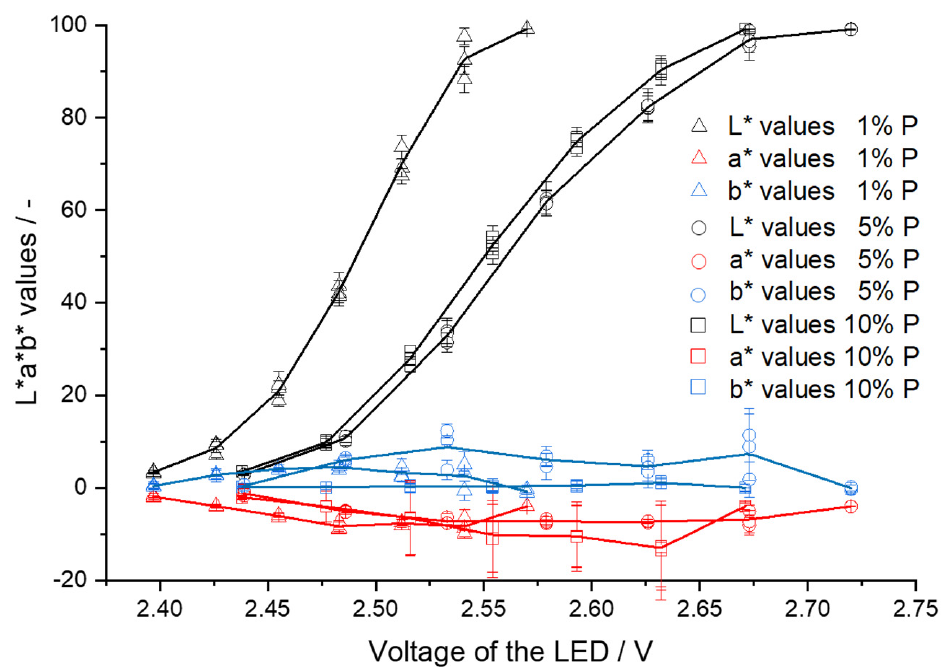
Figure 6. L*a*b* values depending on LED voltage for VA-1% P, VA-5% P, and VA-10% P filaments (mean ± SD, each of the three filaments, n = 6).